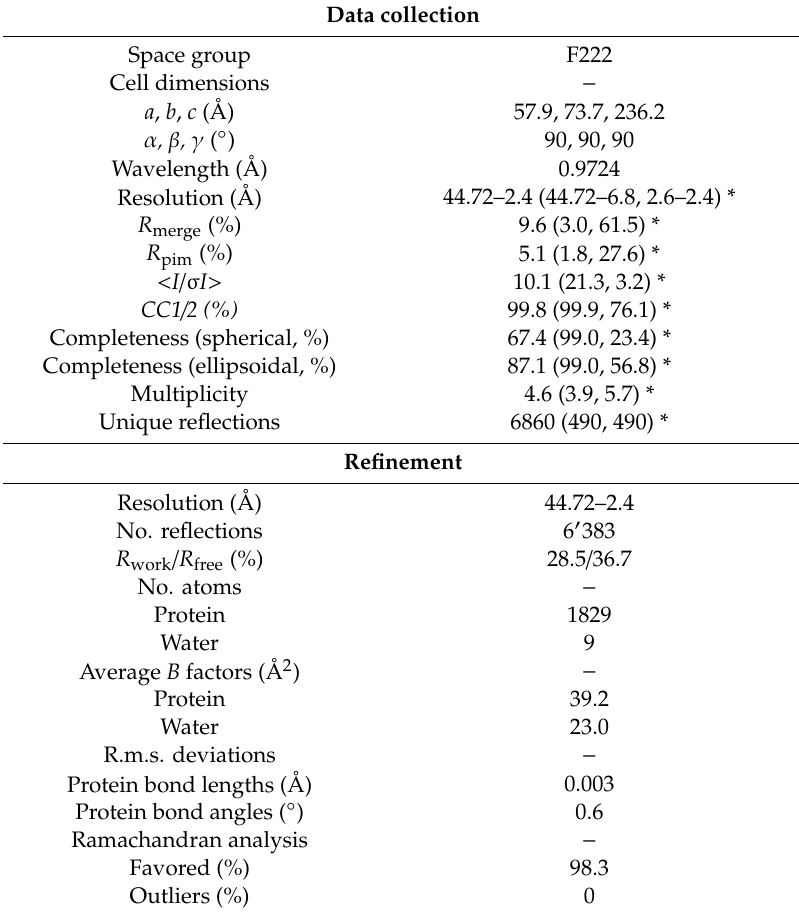
Table 1. Crystallographic data collection and refinement